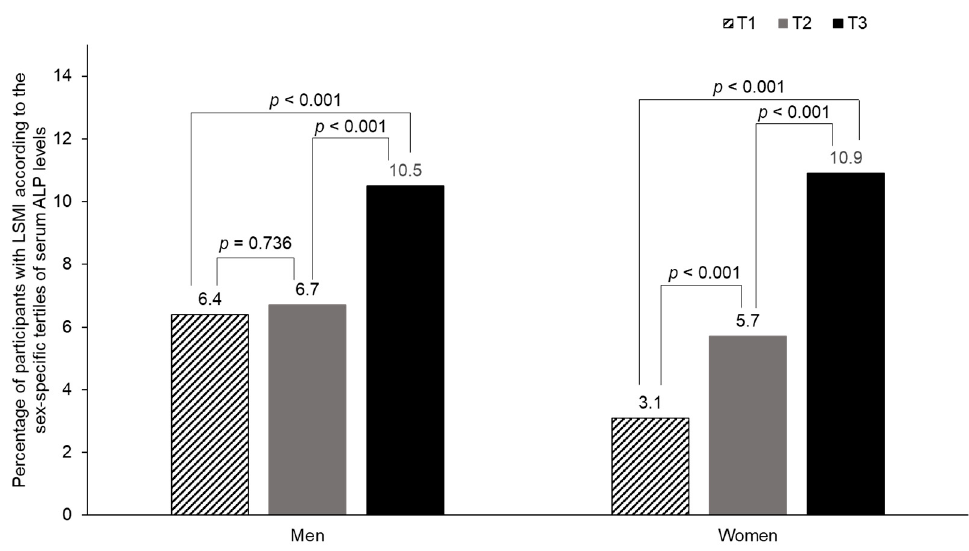
Figure 2. Percentage of participants with LSMI according to the sex-specific tertiles of serum ALP levels.